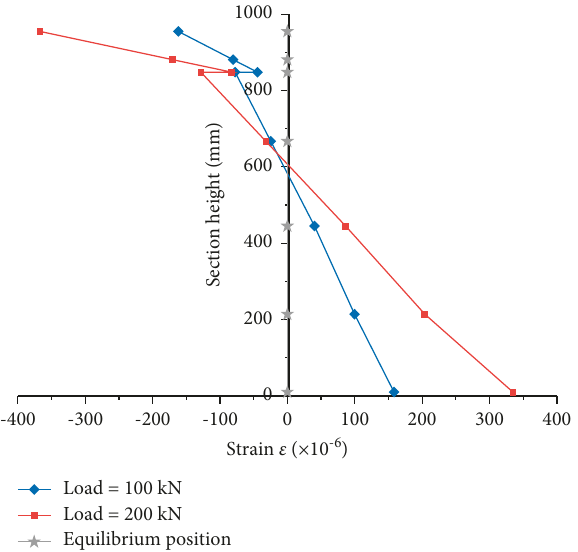
Figure 11: Measured strain of mid-span section of test composite beam.